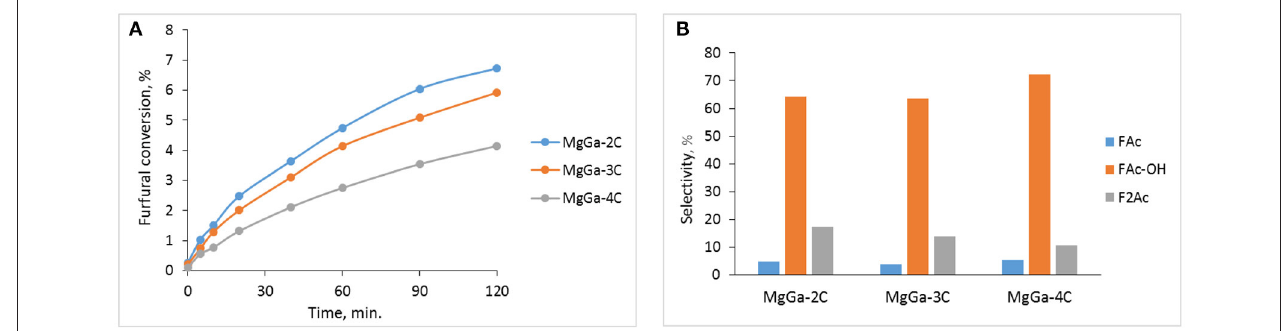
( Figure 12D ). The obtained results show that, independently on chemical composition, the basic sites in the